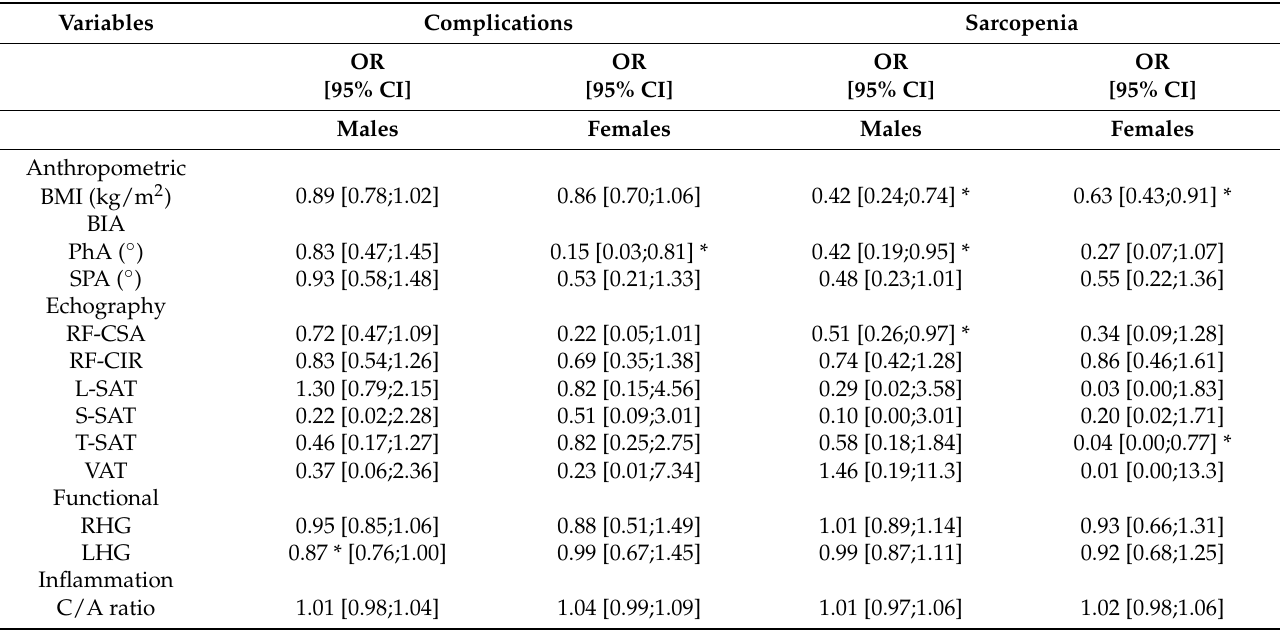
Table 2. Predictive value of phase angle on complications and sarcopenia in patients with colorectal cancer.